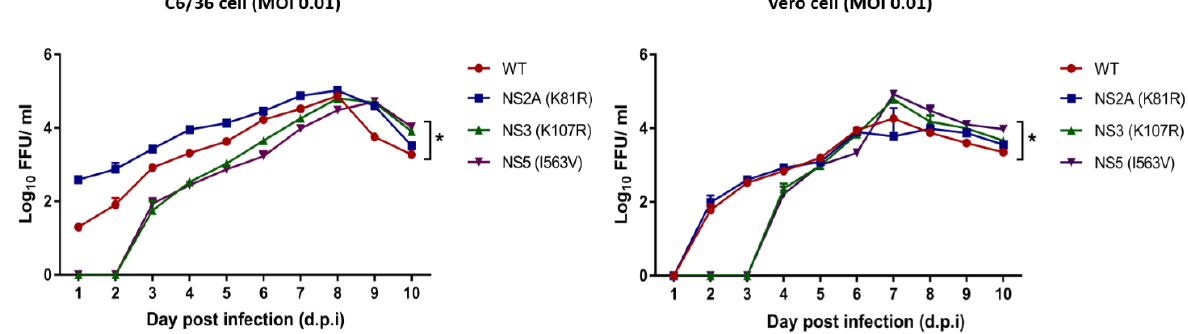
Figure 4. Replication kinetics of DENV-4 wild type (WT), NS2A (K81R), NS3 (K107R), and NS5 (I563V) viruses in C6/36 cells and Vero cells. In vitro experiments were conducted at an MOI of 0.01. The viral titer of the cell culture supernatant was determined from 1 to 10 d.p.i. by immunofluorescence focus assays (IFA). Results are expressed as the mean and SD of triplicate experiments. Statistically significant differences (one-way ANOVA test) between each group are indicated by * p < 0.05 (one-way ANOVA with multiple comparisons, Tukey’s post-test).